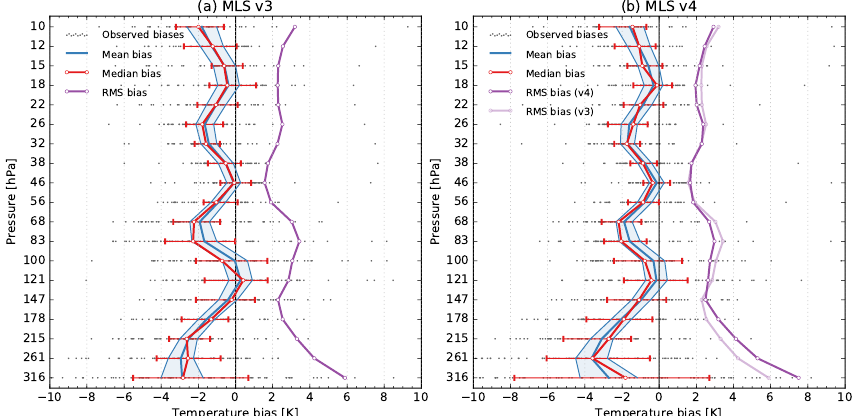
Figure 4. Mean, median and root mean square biases for (a) MLS v3 and (b) MLS v4 temperature profiles relative to RS80 and RS92 temperature profiles interpolated to MLS pressure levels using the respective MLS forward function and averaging kernel. Uncertainty bounds on the mean bias (blue shaded envelope bounded by thin blue lines) represent twice the standard error of the mean, while error bars on the median bias (red error bars) indicate the interquartile range (IQR). Results for individual profiles are shown as grey points. Table 2. Statistical summary of the validation results for MLS v3 (left) and v4 (right) for three atmospheric layers. Layer averages are pressure weighted. The biases of the rms are calculated as the rms MLS value minus the rms sonde value (normalized by the rms sonde value for water vapour and ozone). Correlations are Pearson’s r , tested at the 95% confidence level using Student’s t test. MLS v3 MLS v4 Layer Mean bias rms bias Biases of rms Correlation Mean bias rms bias Biases of rms